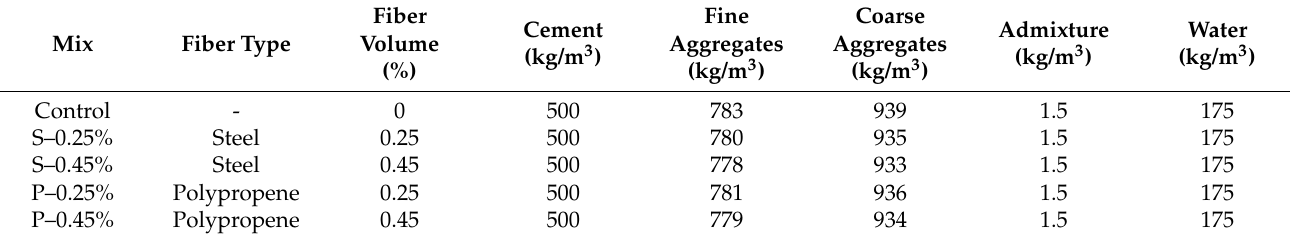
Table 3. Mixtures’